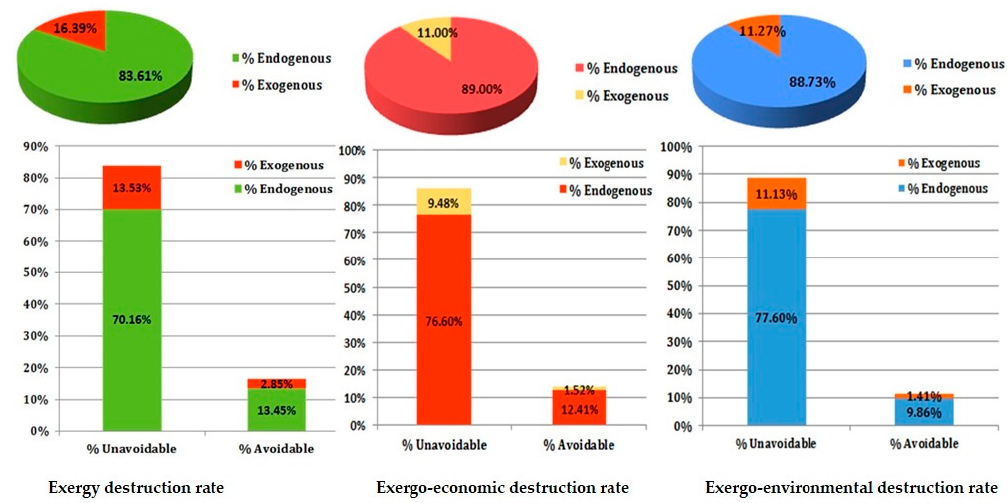
Figure 9. Advanced analysis of exergy destruction rate in the GPP cycle.